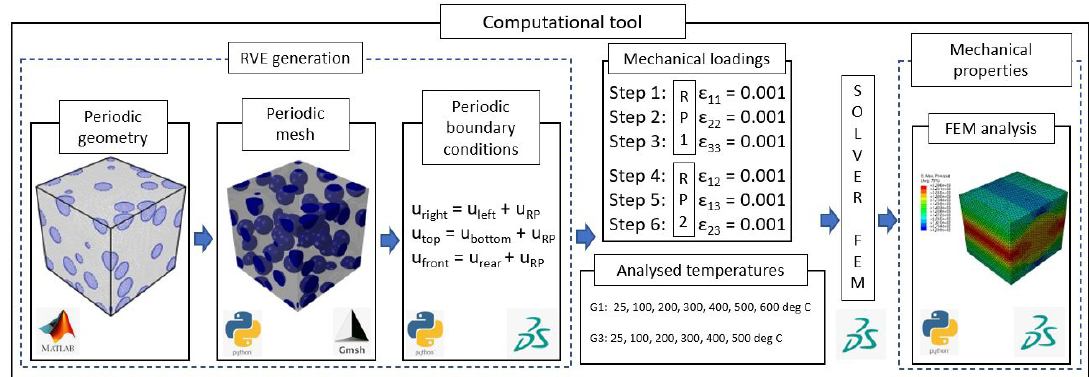
Figure 4. Overview of the computational tool from the RVE creation up to the estimative of elastic properties.